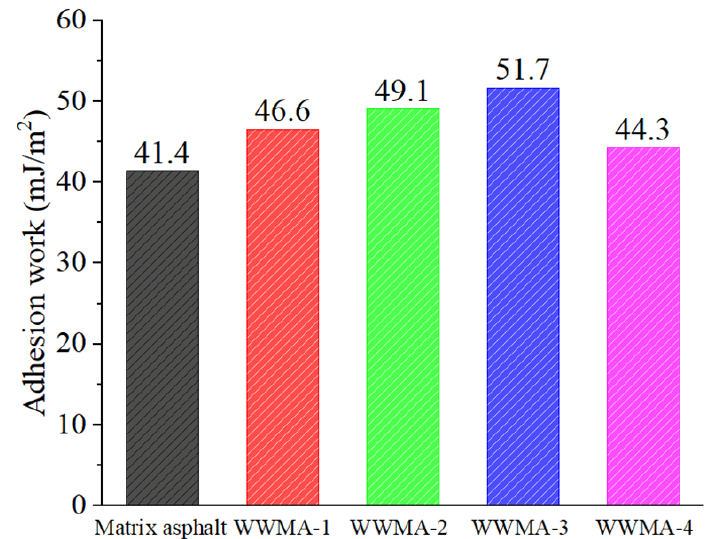
Figure 15. Calculated adhesion work of each asphalt and limestone by the contact angle test.